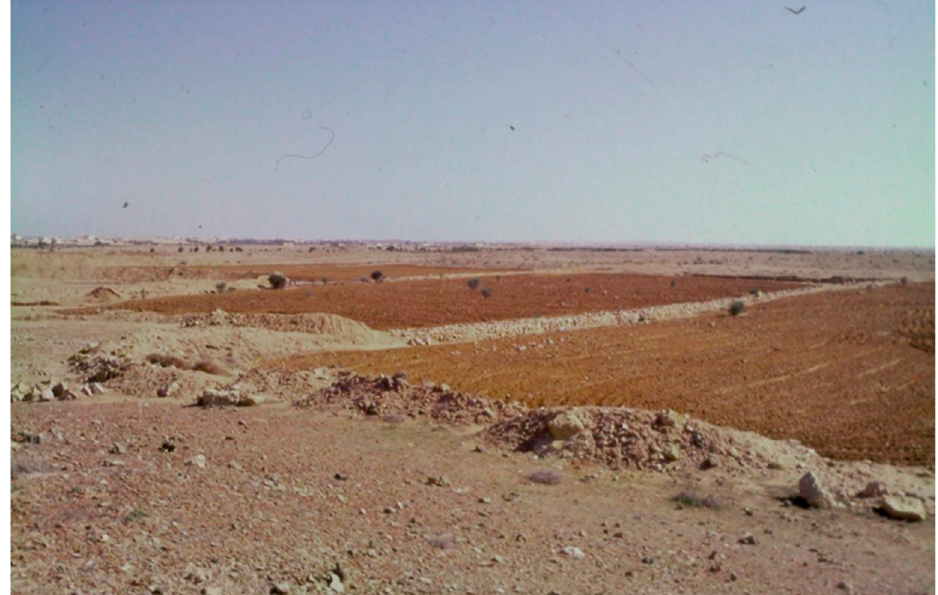
Figure 15. Recent cultivation in the Marmarica Plateau south of Marsa Matrouh. (Photograph: Y. Avni).